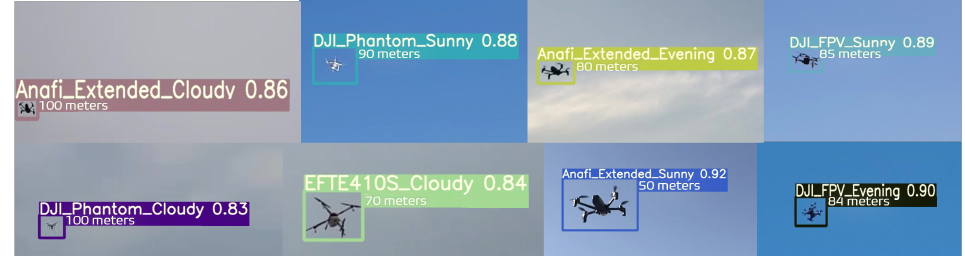
Figure 13. Drone detection samples by the ALIEN model across drone models at different heights and